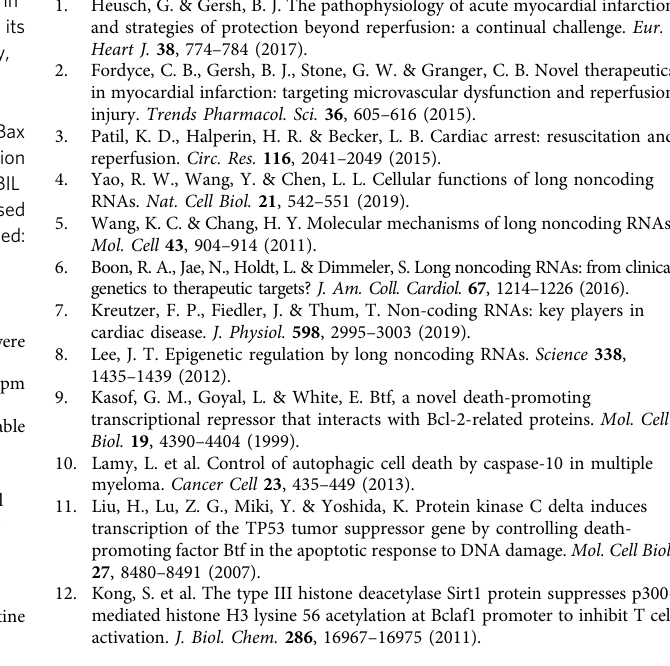
Fig. 8 Schematic showing the proposed mechanism for the effects of lncCIRBIL on cardiac ischemia – reperfusion injury. LncCIRBIL localizes in the cytoplasm of cardiomyocytes where it binds Bclaf1 protein to prevent its translocation to the nucleus. During cardiac ischemia – reperfusion injury, lncCIRBIL expression is reduced, which favors the dissociation of Bclaf1 protein from its binding state to become free for nuclear translocation. After entering the nucleus, Bclaf1 activates the transcription of p53 and Bax to induce cardiomyocyte apoptosis leading to cardiac ischemia – reperfusion injury. Meanwhile, p53 negatively regulates the transcription of lncCIRBIL and upregulation of p53 causes further downregulation of lncCIRBIL.